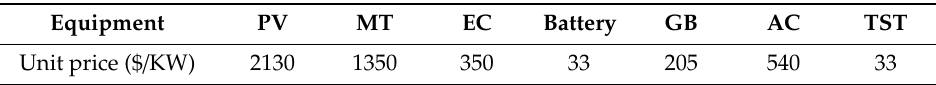
Table 2. Equipment cost of the CCHP